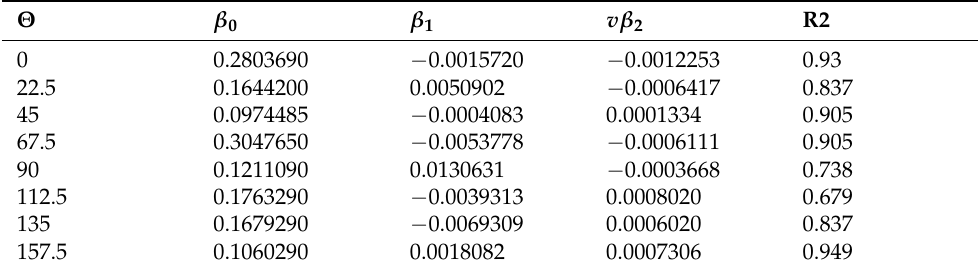
Figure 6. Effects of fibre angle on ACOF with machining velocities: ( a ) 1 m/min, ( b ) 5 m/min, ( c ) 10 m/min and ( d ) 15 m/min. Table 2. MLR